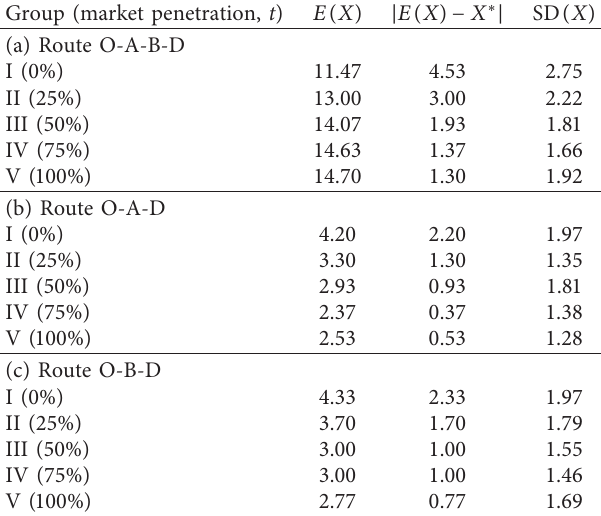
Figure 3: Flow fluctuation of three routes in five groups of experiments. (a) Group I, (b) Group II, (c) Group III, (d) Group IV, and (e) Group Table 3: Mean and standard deviation of traffic volume on each route in each group of experiments.